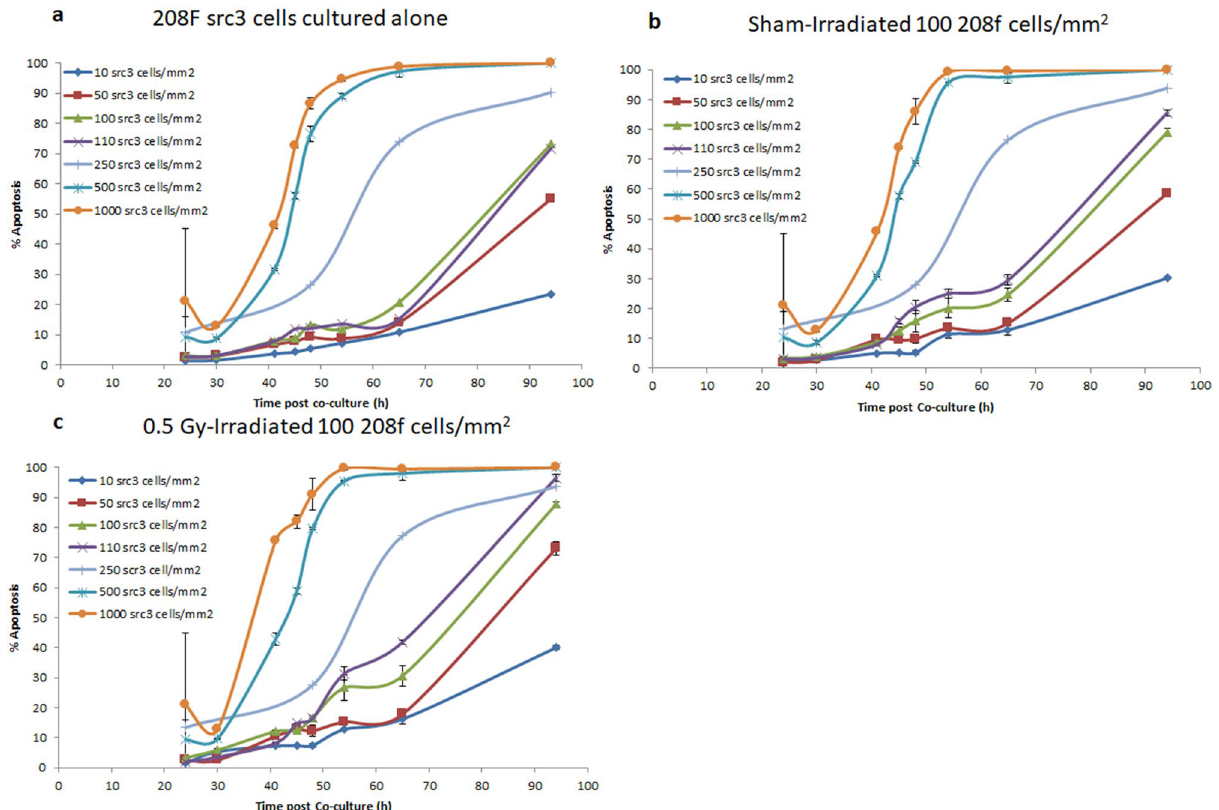
Figure 2. Low density 208F cells and varying density of 208F src3 cells. Apoptosis induction in transformed 208F src3 cells seeded at seeding densities 10, 50, 100,110, 250, 500 and 1000 cells/mm 2 cultured in the absence ( a ) or presence of sham- ( b ) or 0.5 Gy γ-irradiated ( c ) non-transformed 208F cells at a seeding density of 100 cells/mm 2 . Each data point is a mean value derived from three independent experiments. Error bars represent the standard deviation derived from three independent